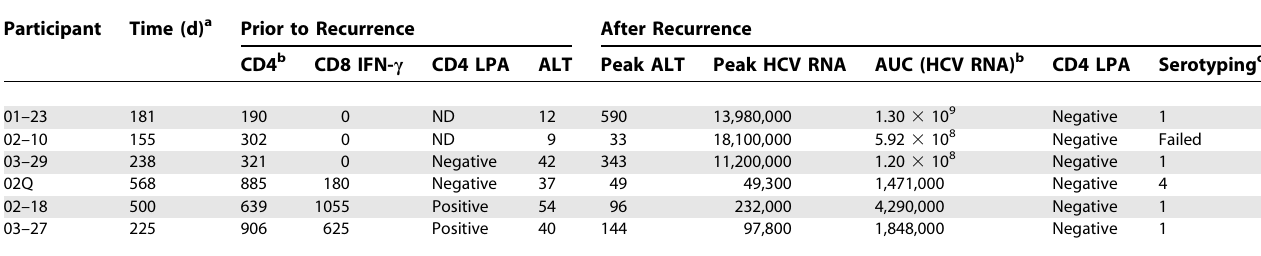
Table 3. Clinical Data and Outcomes of Six HCV Recurrences in HIV þ Persons with Prior Control of HCV Participant